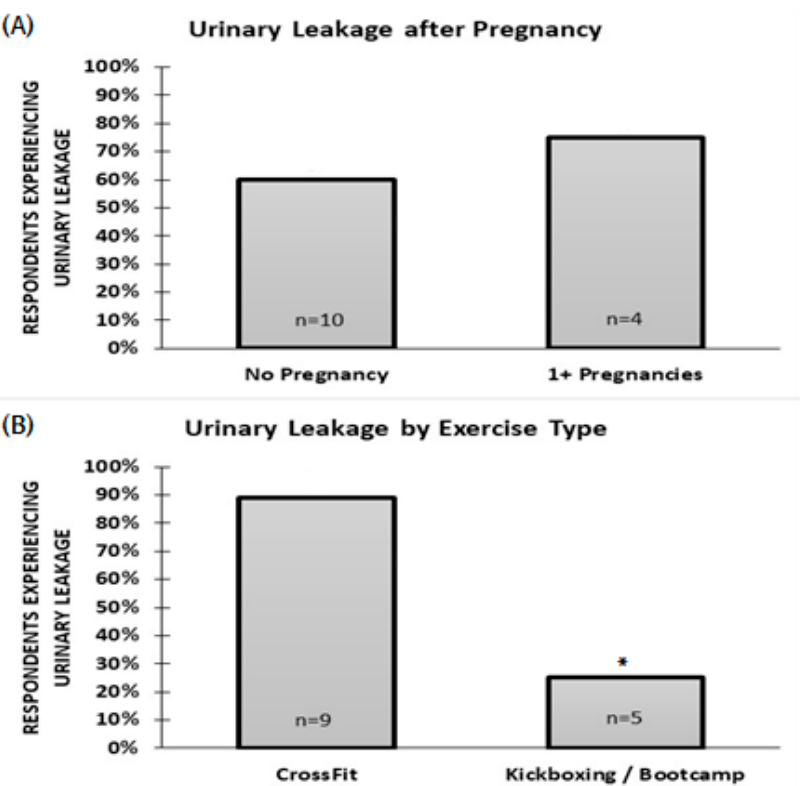
Figure 1. ( A ): Percent of respondents experiencing urinary leakage based on past pregnancy. ( B ): Percent of respondents experiencing urinary leakage based on exercise type. * statistical significant of the of urinary leakage between exercise type; Fisher’s exact test. Table 2. Urinary incontinence episode frequency and amount of urine leakage reported by survey respondents.